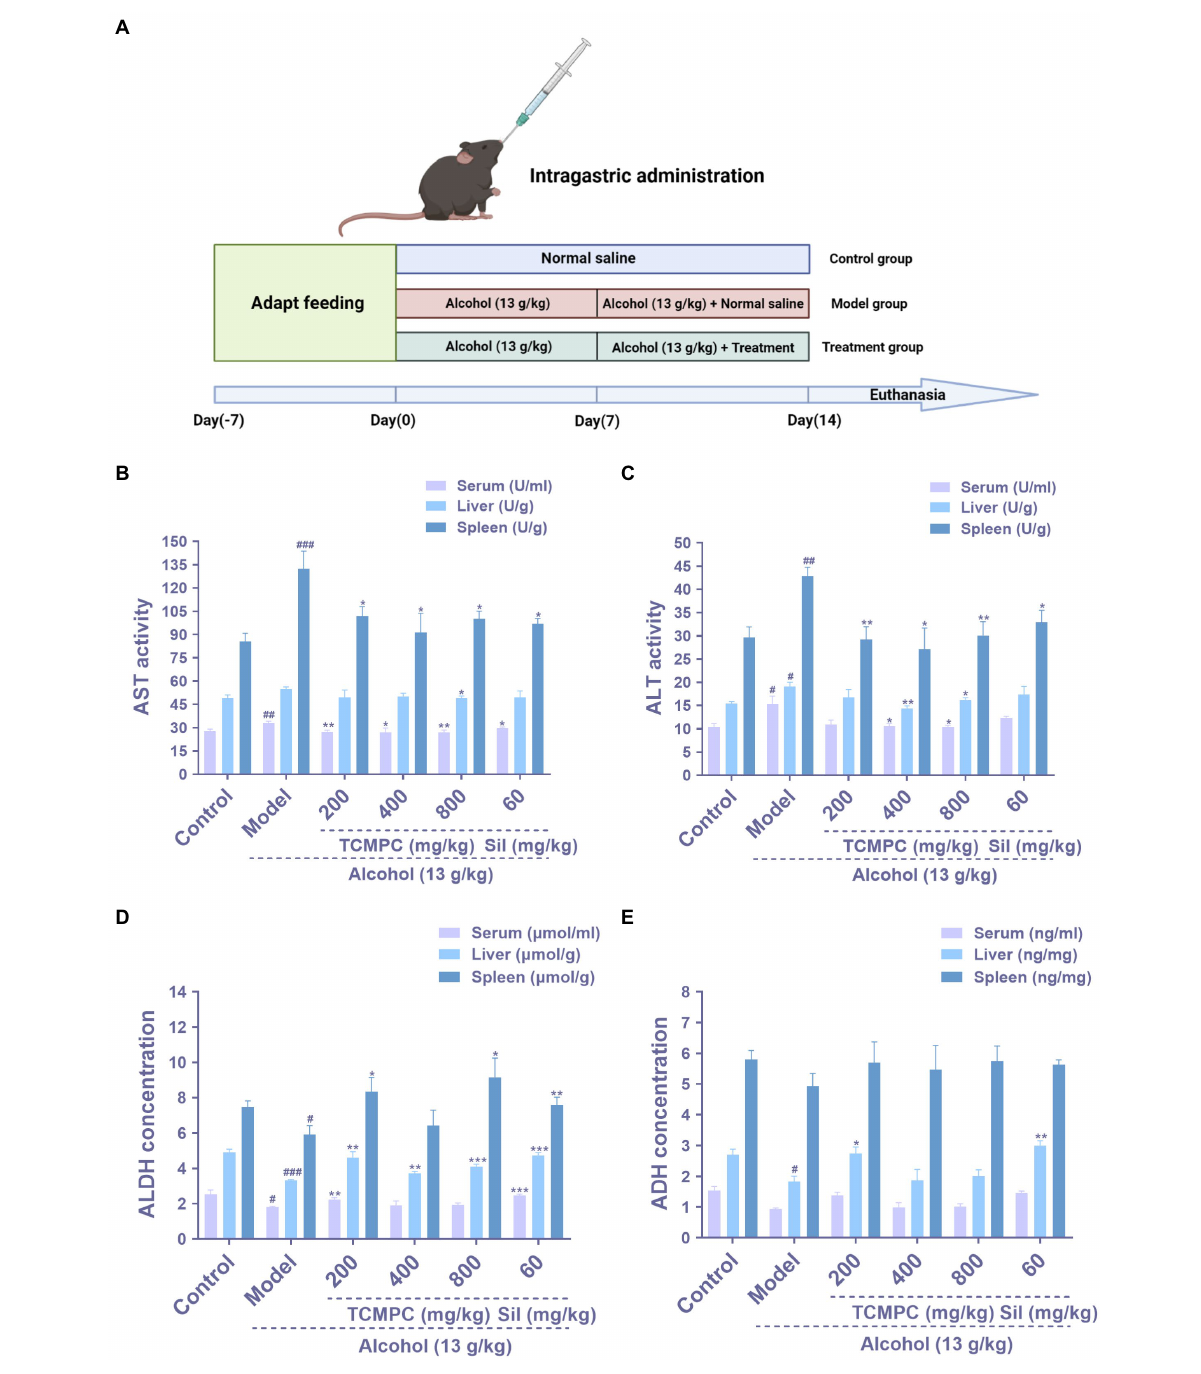
MDA is a product of lipid peroxidation, and its overexpression indicates oxidative stress in the body (44). The ROS, MDA, and NO levels of serum, liver, and spleen were significantly increased ( p < 0.05; Figures 2A–C) in model group compared to the control group. The levels of ROS, MDA, and NO in serum of mice in the control group